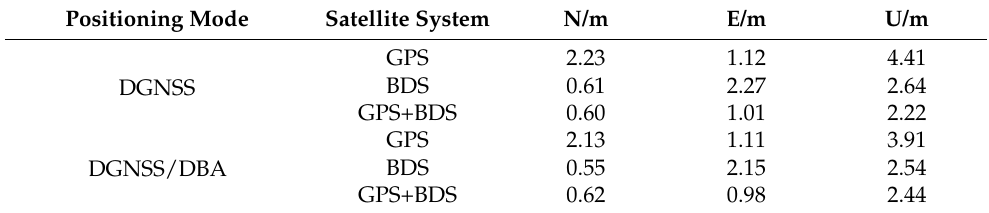
Figure 9. Observation values of static experiment at the baseline length of 6.0 km: ( a ) the number of GNSS visible satellites; ( b ) the sequence of PDOP values. Table 5. The RMSE of bias in the N/E/U directions for the DGNSS and DGNSS/DBA mode at 6.0 km baseline length.